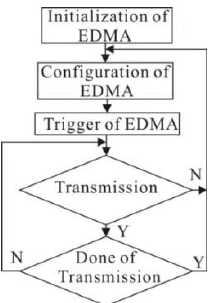
Figure 10. Work flow of EDMA